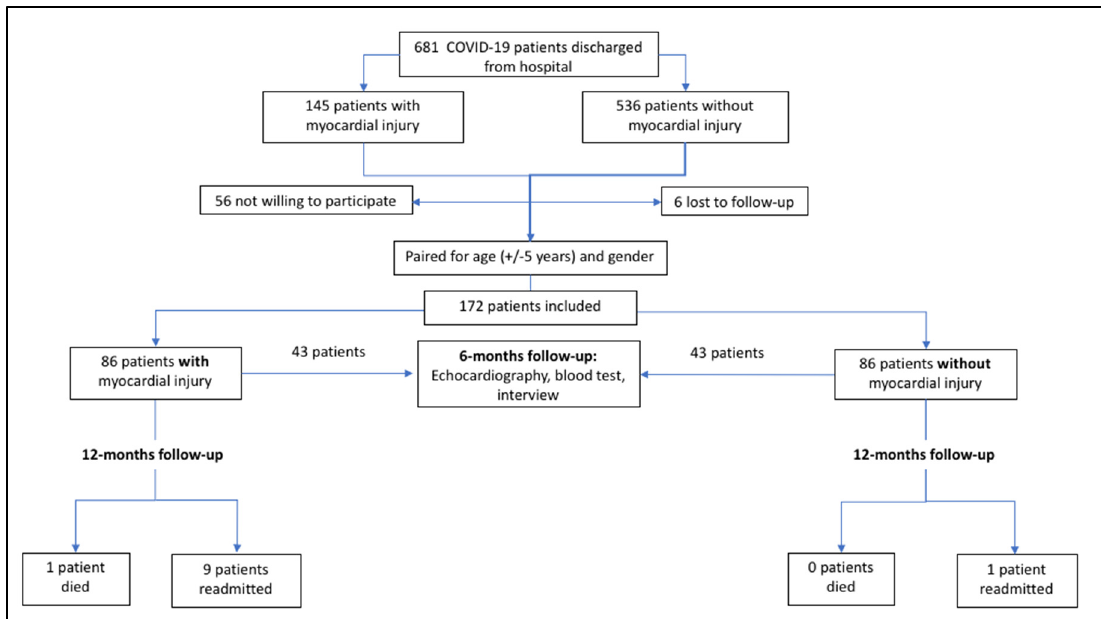
Figure 1. Flow chart showing inclusion of patients with COVID-19 in the study.